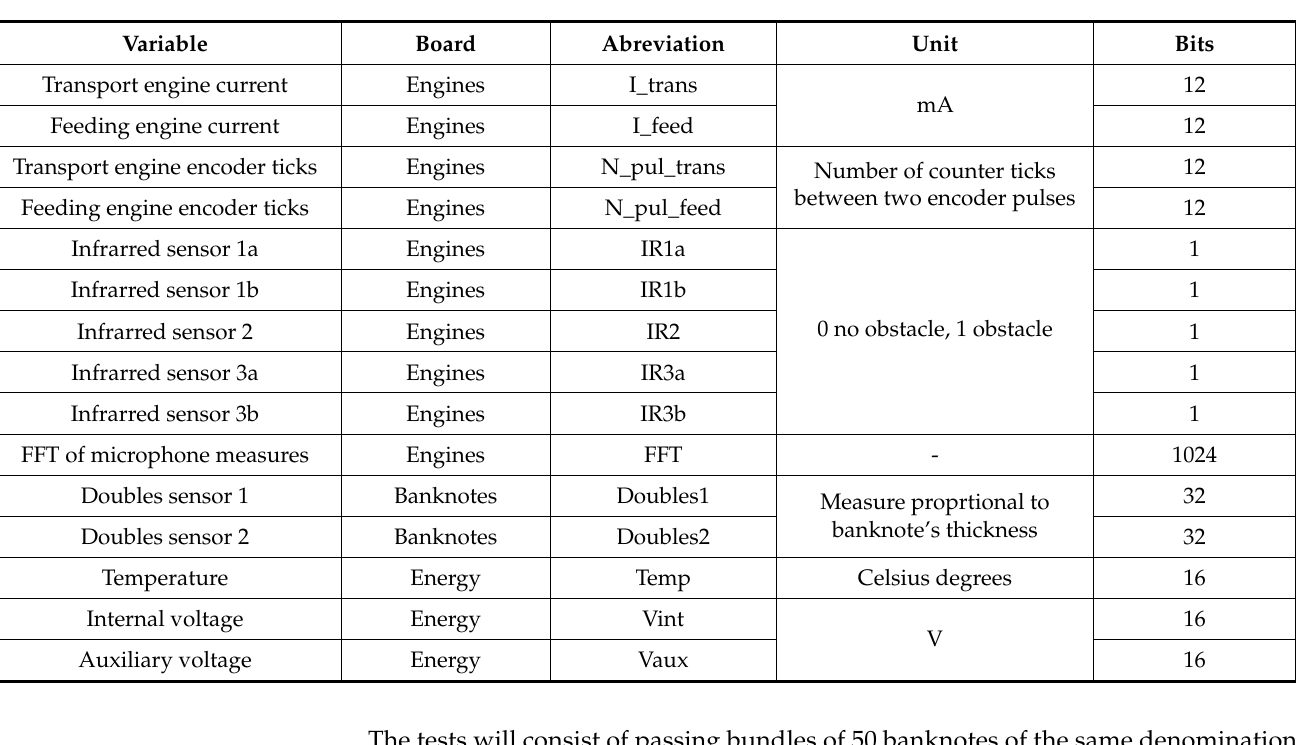
Table 1. Summary of the variables monitored.